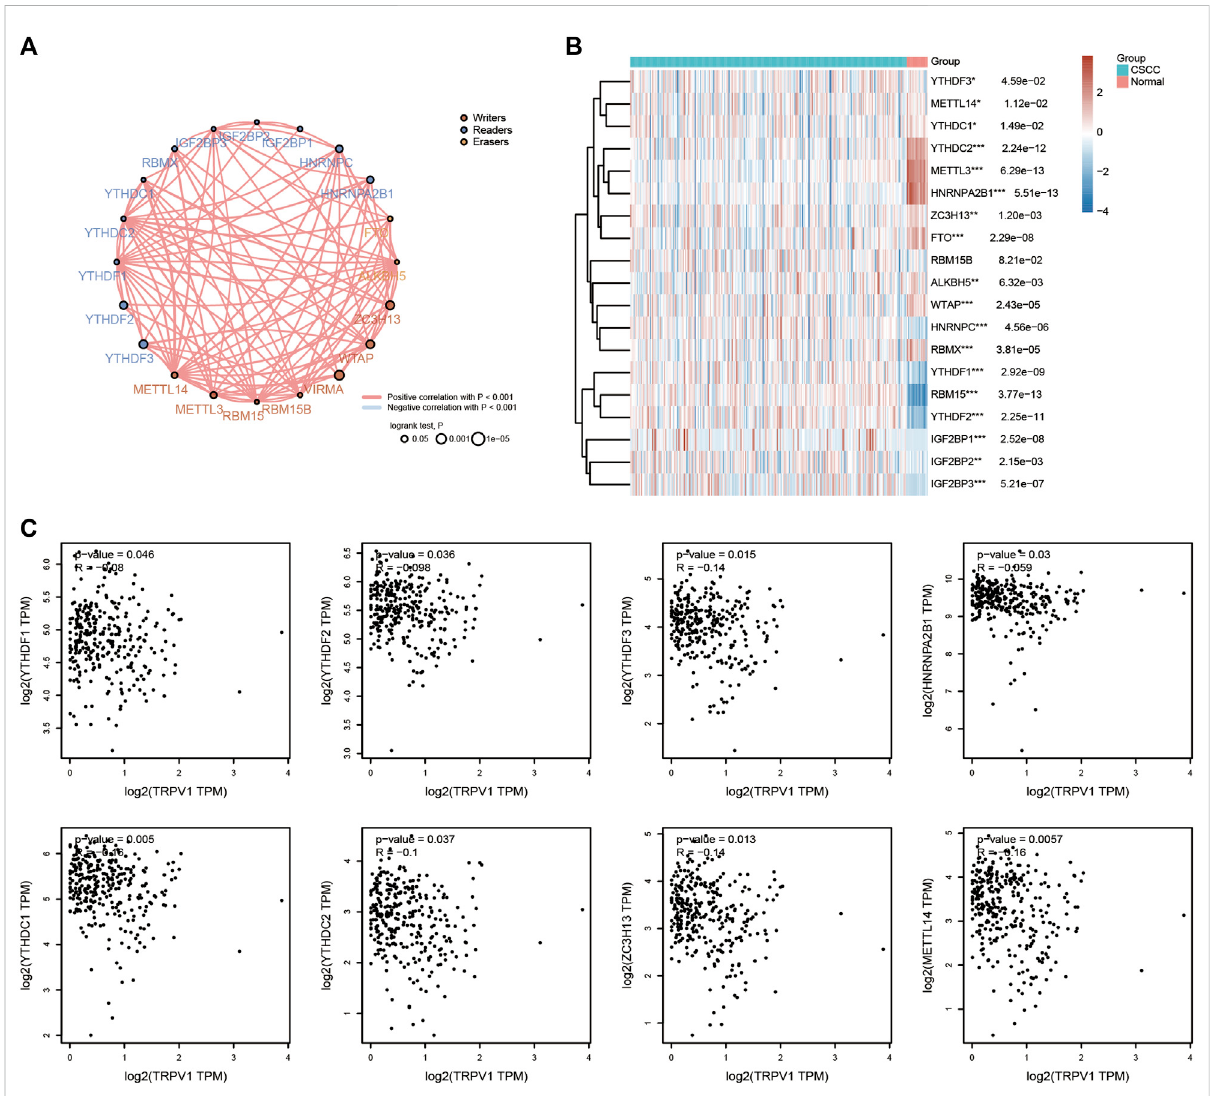
Effects of TRPV1 on methylases. (A) Circles represent the m6A-related mRNA, line represents the relationship between genes. Red represents positive correlation whereas blue represents negative correlation, the thicker the line, the higher the correlation coef fi cient. The larger thecircle the smaller log rank p. Different colors of circles represent writers, readers and erasers. (B) The heatmap of m6A related gene expression. The different colors represent the trend of gene expression in different samples. * p < 0.05, ** p < 0.01, *** p < 0.001, asterisks (*) stand for signi fi cance levels. The statistical difference of two groups was compared through the Wilcox test, signi fi cance difference of three groups was tested with Kruskal – Wallis test. (C) Effects of TRPV1 on methylases including YTHDF1/2/3, HNRNPA2B1, YTHDC1/2, ZC3H13, and